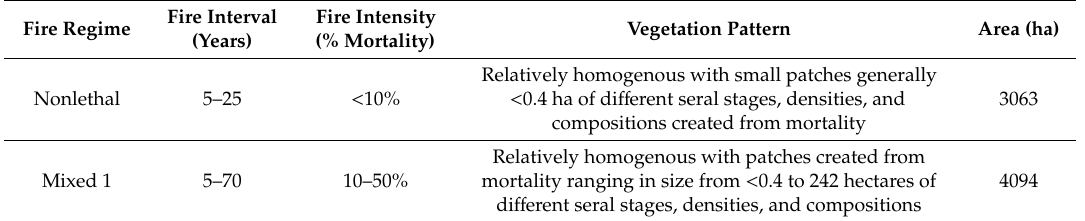
Figure 1. Becker Project Area of the Boise National Forest and its location within the state of Idaho, stand areas are indicated in blue. Table 1. Fire regimes, area [20] and vegetation pattern [21] for treatment areas.